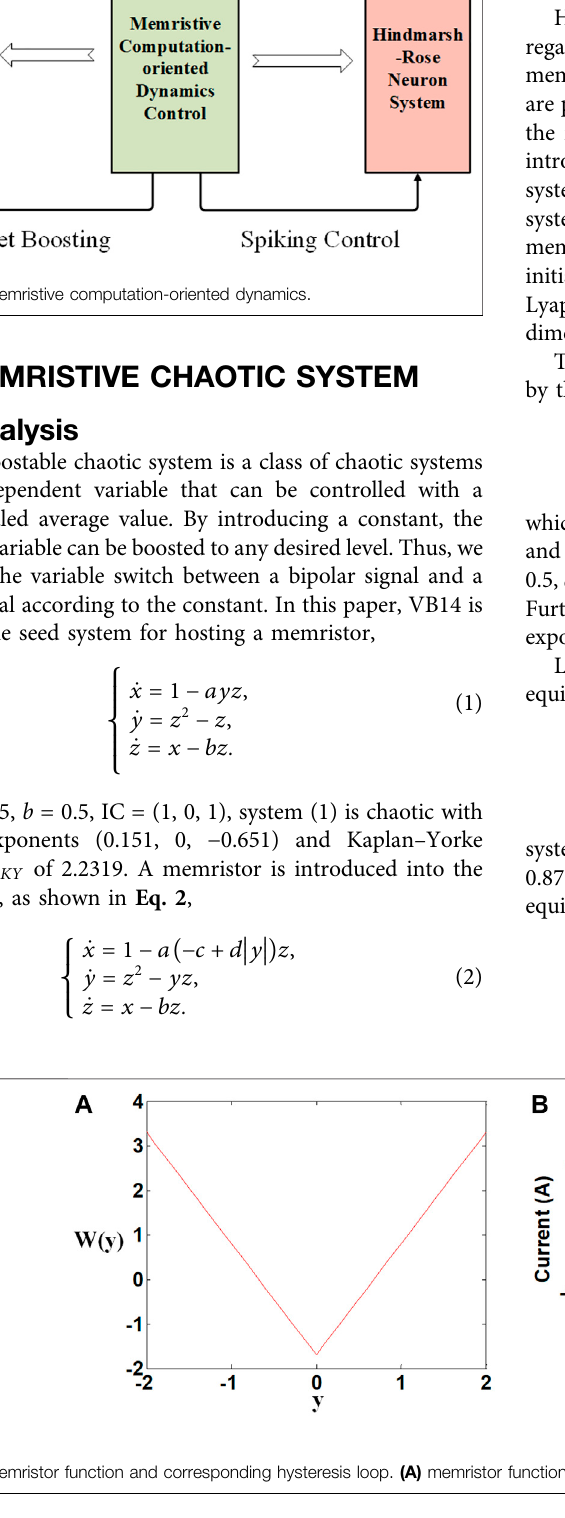
Frontiers in Physics |